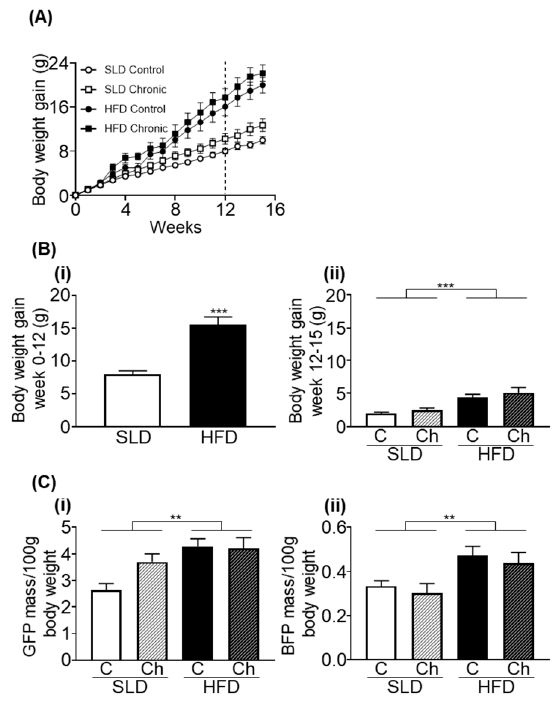
Figure 1. High fat diet (HFD) feeding but not the chronic isoleucine treatment increased weight gain and adiposity in mice. ( A ) Body weight gained during weeks 0–15 in mice fed a standard laboratory diet (SLD) or HFD (SLD / HFD-Control (C; control and acute groups pooled as no acute gavage of isoleucine had occurred at this point) n = 16–20; SLD / HFD-Chronic (Ch) n = 8–10). The dotted line indicates the onset of chronic isoleucine supplementation. ( B ) ( i ) Body weight gained during week 0–12 in SLD or HFD ( n = 24–30 / group; all HFD and SLD groups pooled as no chronic or acute isoleucine treatment had occurred at this point); *** p < 0.001 unpaired t-test. ( ii ) Body weight gained in week 12–15 (SLD / HFD-Control (C; control and acute groups pooled as no acute gavage of isoleucine had occurred at this point) n = 16–20; SLD / HFD-Chronic (Ch) n = 8–10). ( C ) ( i ) Gonadal fat pad (GFP) mass and ( ii ) brown fat pad (BFP) mass per 100 g of total body weight ( n = 8–10 / group). Values are mean ± SEM. ** p < 0.01, *** p < 0.001; diet e ff ect, two-way ANOVA.